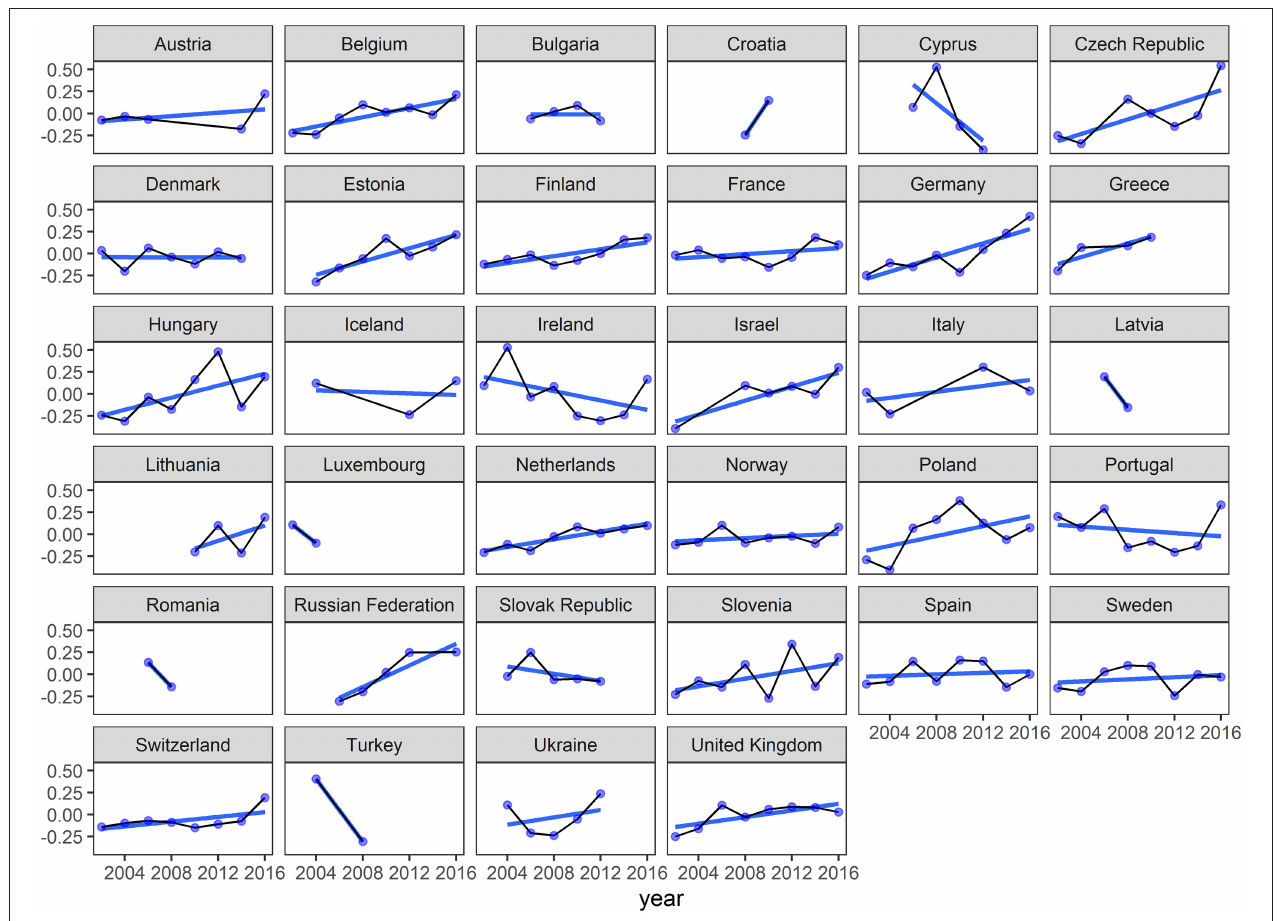
FIGURE 2 | Within-country social trust over